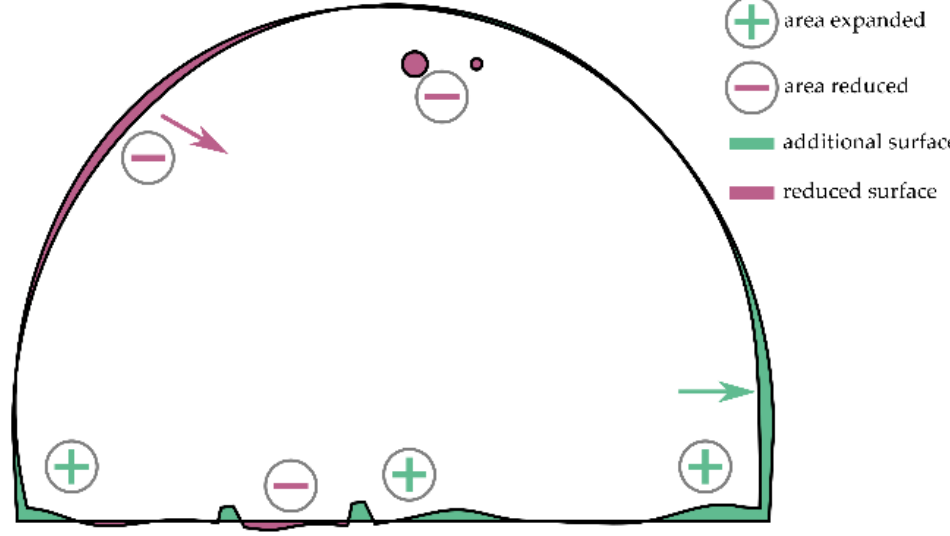
Figure 12. Differences in cross-sections between reference method and CAD method; cross-section 1.2.